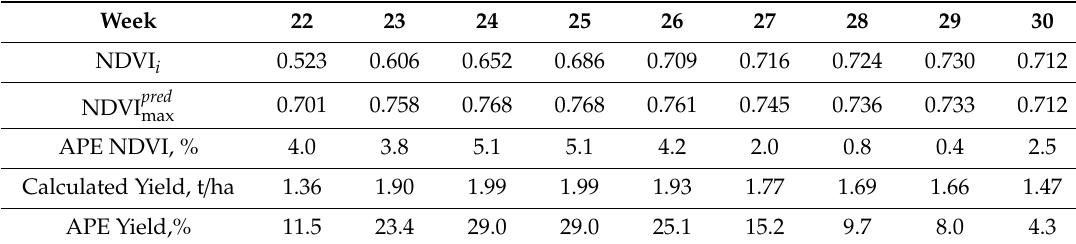
Table 10. NDVI values (observed in i th week); NDVI maxima, soybean yield, and absolute percentage errors in 2019 in the Khabarovsk District, calculated using the approximating function in the 22nd (June 1) to 30th (July 30) calendar weeks.